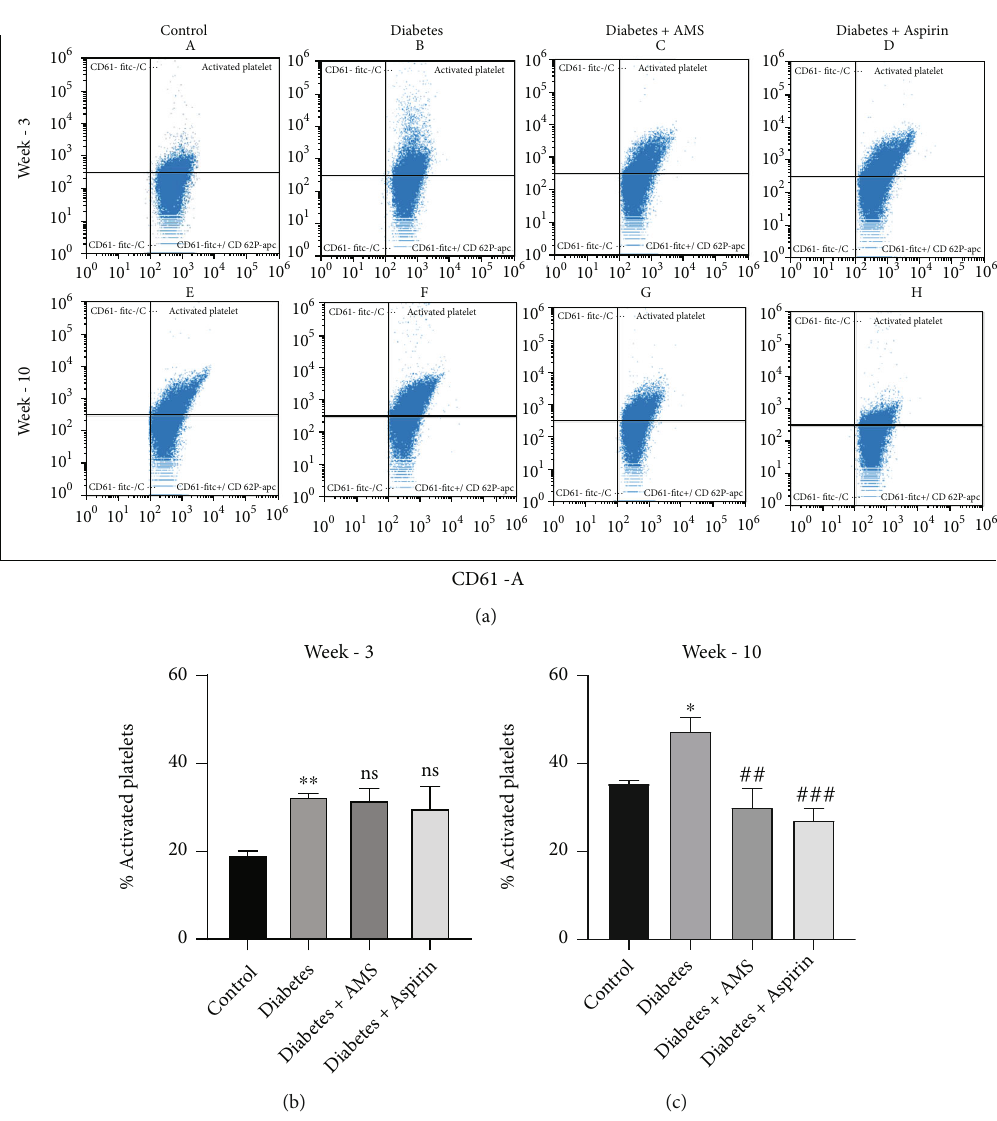
Figure 2: Flow cytometry analysis of platelet activation showing percentage dual positive cells (CD61+, CD62P+). (a) Representation of the scattered plots of percentage platelet activation in the control (A, E), diabetes (B, F), AMS-treated diabetic (C, G), and aspirin-treated diabetic (D, H) groups after 3 and 10 weeks of study. Bar graph showing percentage platelet activation at the end of the 3rd week (b) and 10th week (c). All values are represented as mean ± SEM ( N = 4 -5). ∗ p < 0 : 05 vs. the control; ∗∗ p < 0 : 01 vs. the control; ## p < 0 : 01 vs. diabetes; and ### p < 0 : 001 vs diabetes; ns: nonsigni fi